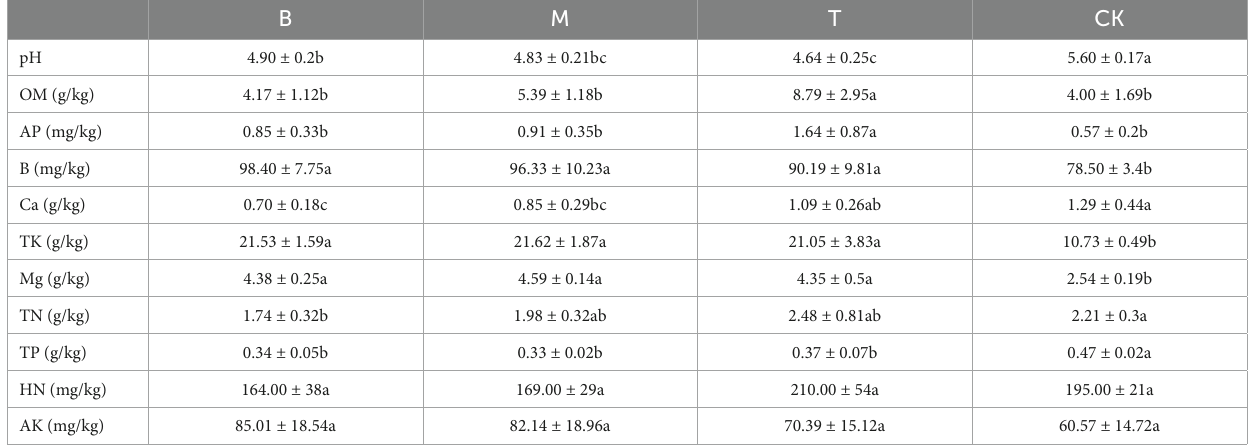
Data are given as mean ± SD. B, bottom slope; M, middle slope; T, top slope. Values in the columns followed by the same letter(s) are not significantly different ( p < 0.05) according to one-way ANOVA. TABLE 6 The difference of soil properties in different slope positions of sunny slope.